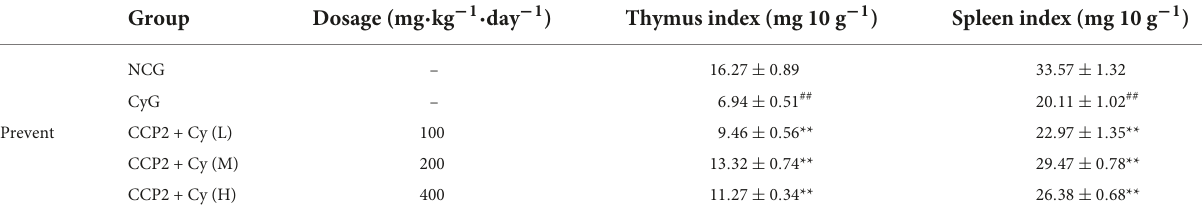
TABLE 3 The thymus and spleen index of immunocompromised mice.